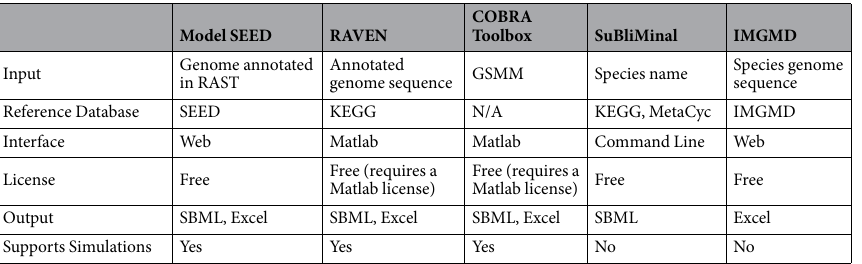
Table 1. Selected characteristics of software platforms for reconstruction and simulation of metabolic